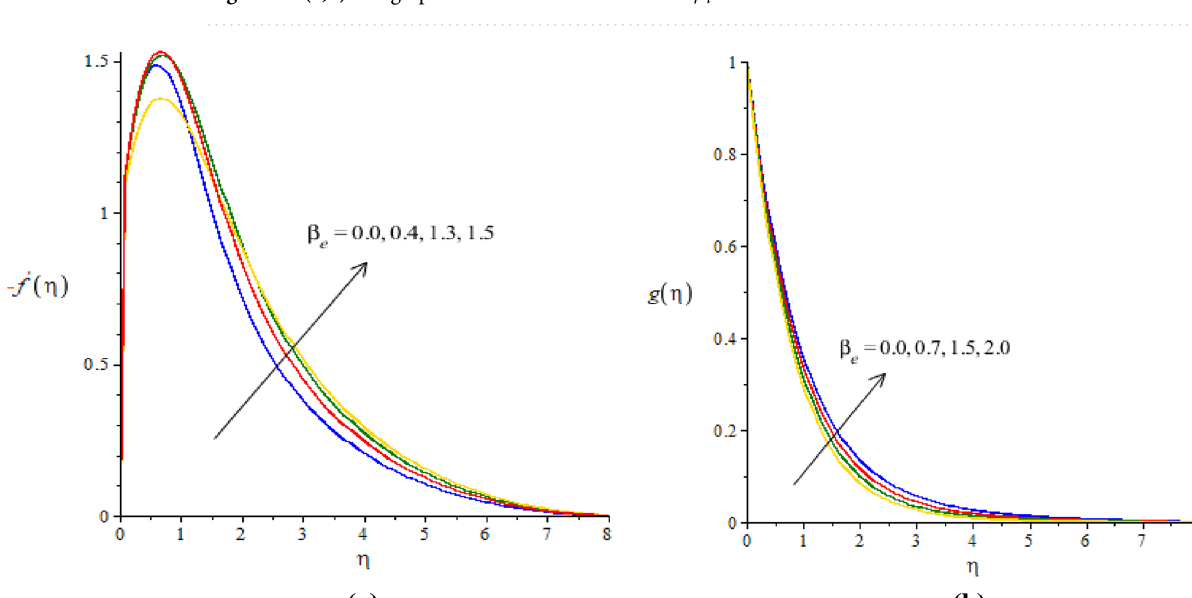
Figure 5. (a,b) The graphical view of velocities versus β e